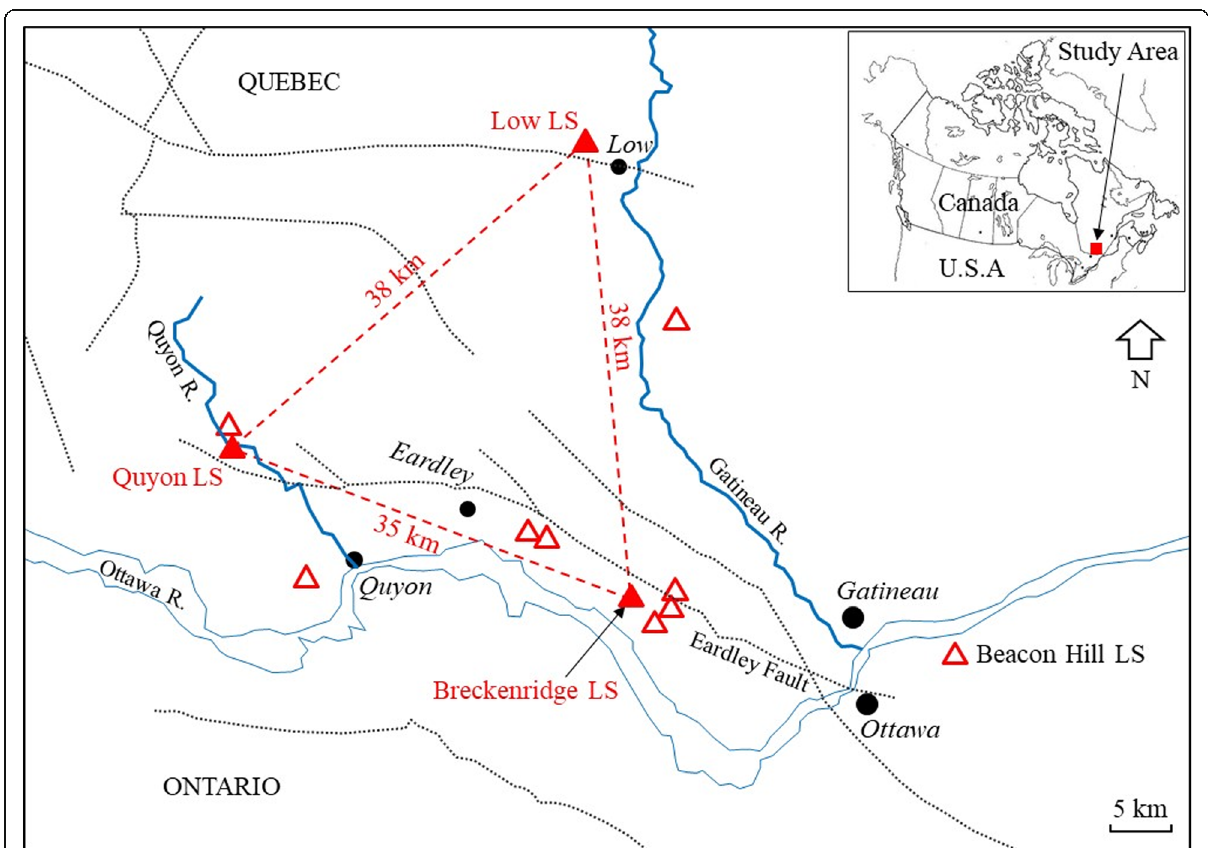
Fig. 1 Location map of the study area. Solid triangles mark the headscarp locations of the study landslides. Hollow triangles are the locations of other landslides of ~ 1020 cal BP (after Brooks 2015). Dotted lines are some major faults of interest in the region (after Atkinson et al. 2014, Bent et al. 2015, and Lamontagne et al.